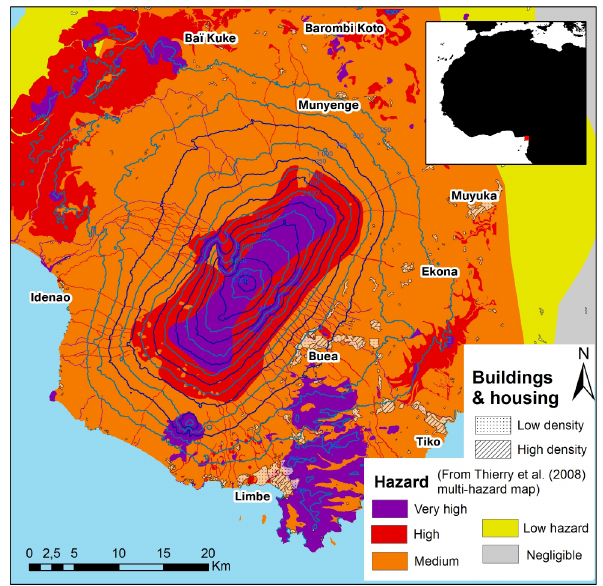
Figure 4. Map of Mount Cameroon showing the multi-hazard map (Thierry et al., 2008), topographical isolines (bins of 250m) and the location of main towns. This hazard maps combines threats due to lava flows, ground instability, ash fall, tsunamis and earthquakes. The map highlights that besides volcanic hazards, the hilly areas in the east of Limbe are subject to very high hazard of landslides.